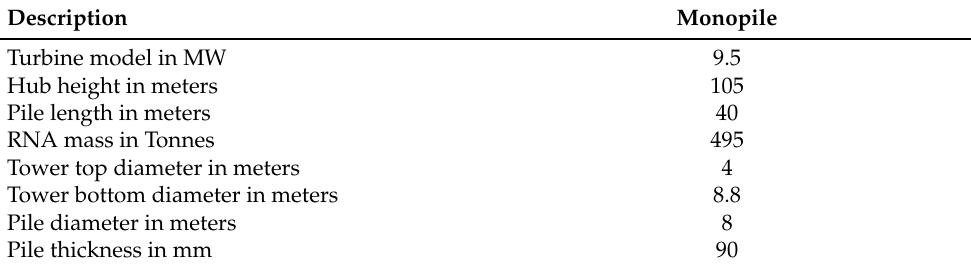
Table 4. Input data of the structures and the monopile foundation.